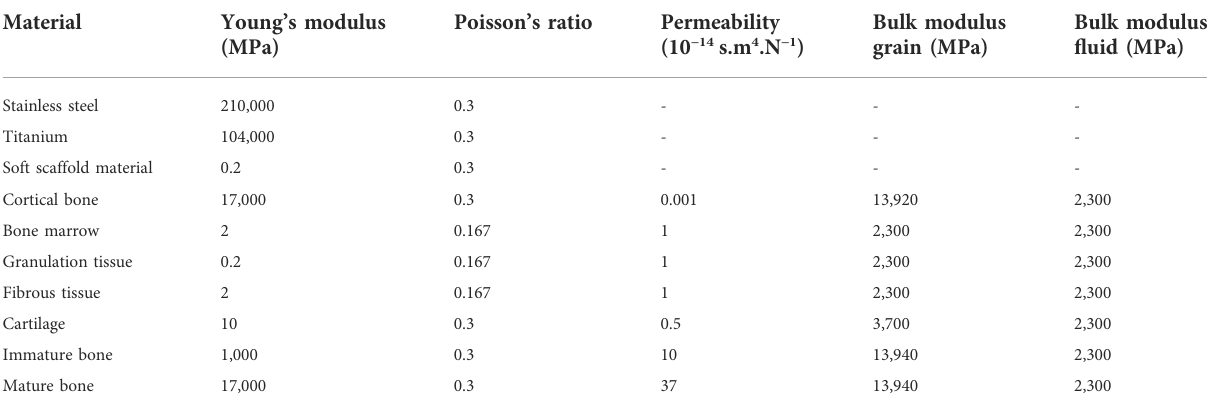
TABLE 1 Material properties (Perier-Metz et al.,